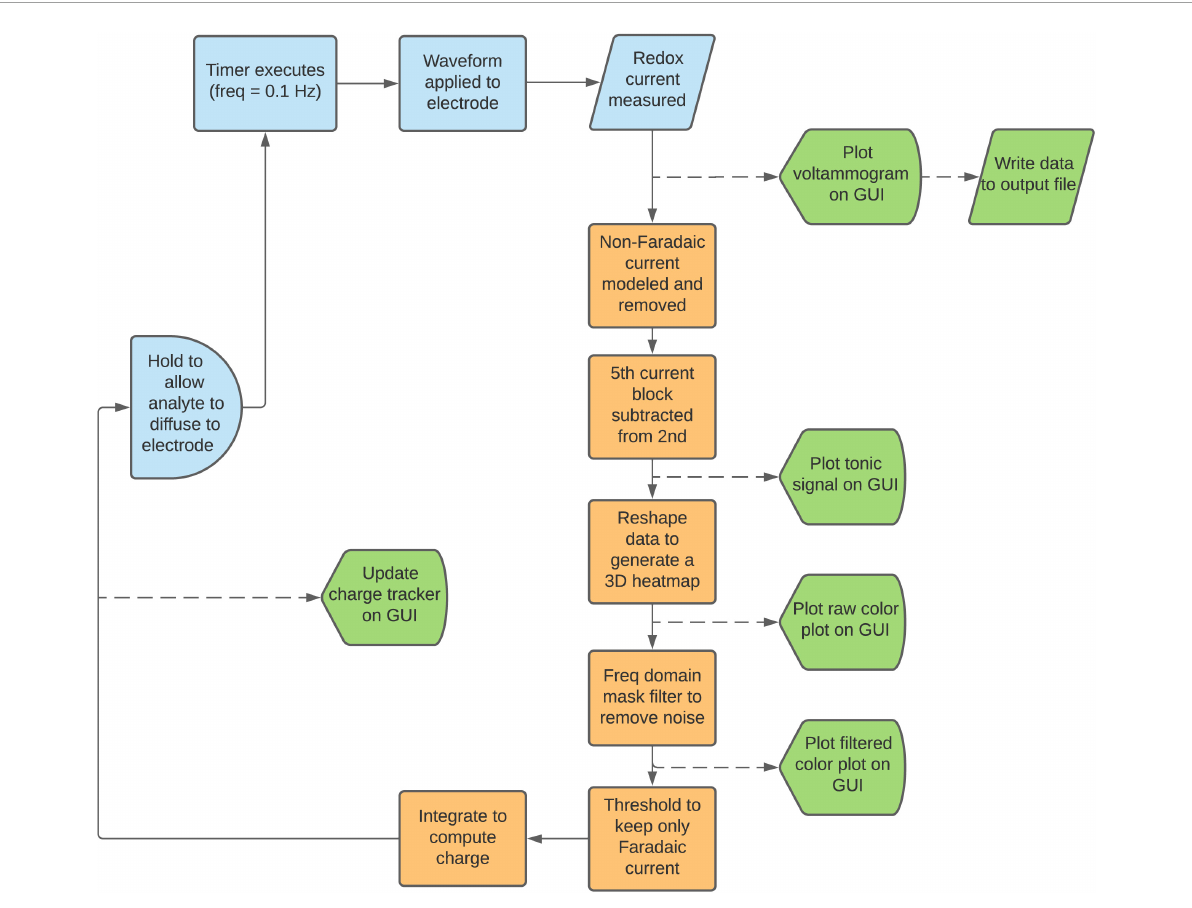
FIGURE3 Data analysis flowchart. Starting from the upper left, the workflow proceeds as described in the manuscript. Squares denote processes, semicircles denote delay blocks, rhombi denote data I/O blocks, and pentagons denote display blocks. Processing steps that occur without user input are denoted in orange, and data that is plotted to the GUI ( Figure 4 ) are denoted in